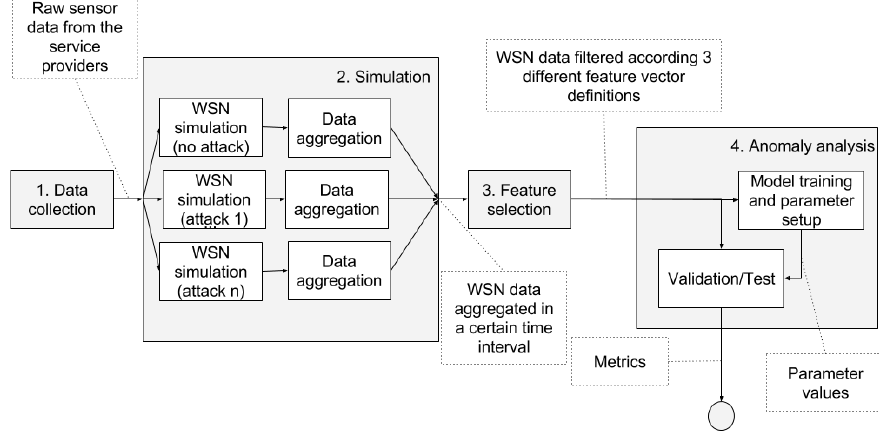
Figure 1. Pipeline of the simulation and the experimental process.